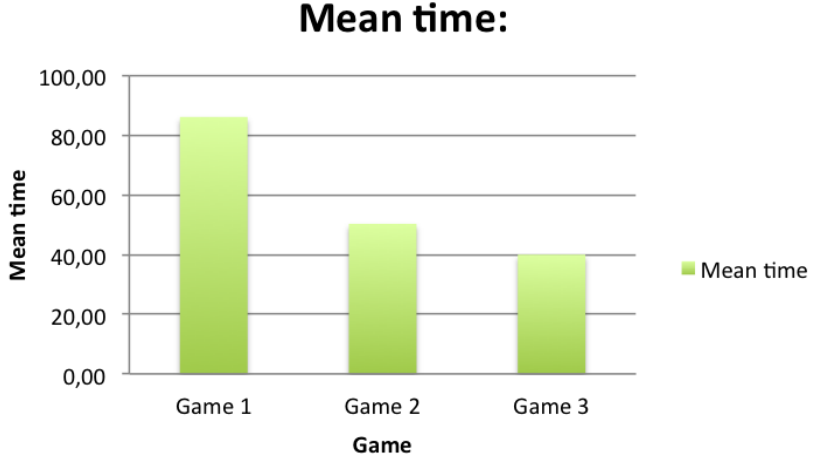
Figure 9. Graph representing the mean time obtained in each